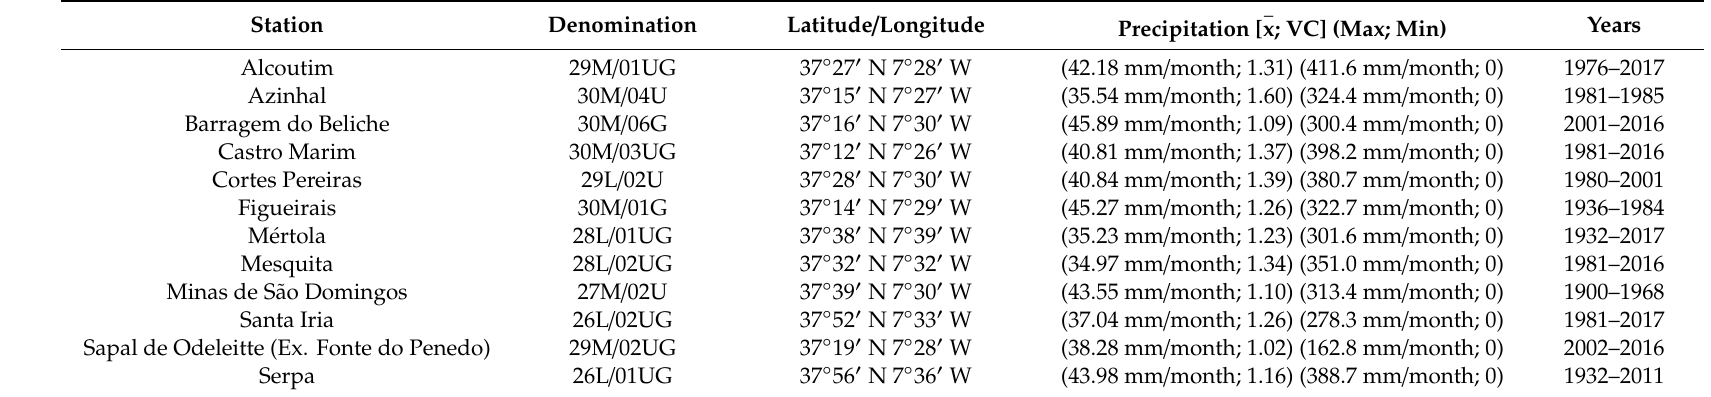
Table 3. Characteristics of Portuguese climatic stations distributed over the Lower Guadiana River Basin (control network SNIRH, Figure 2) ( precipitation in mm / month; VC = variation coe ffi cient; max = monthly maximum precipitation in mm / month; min = monthly minimum precipitation in mm / month)